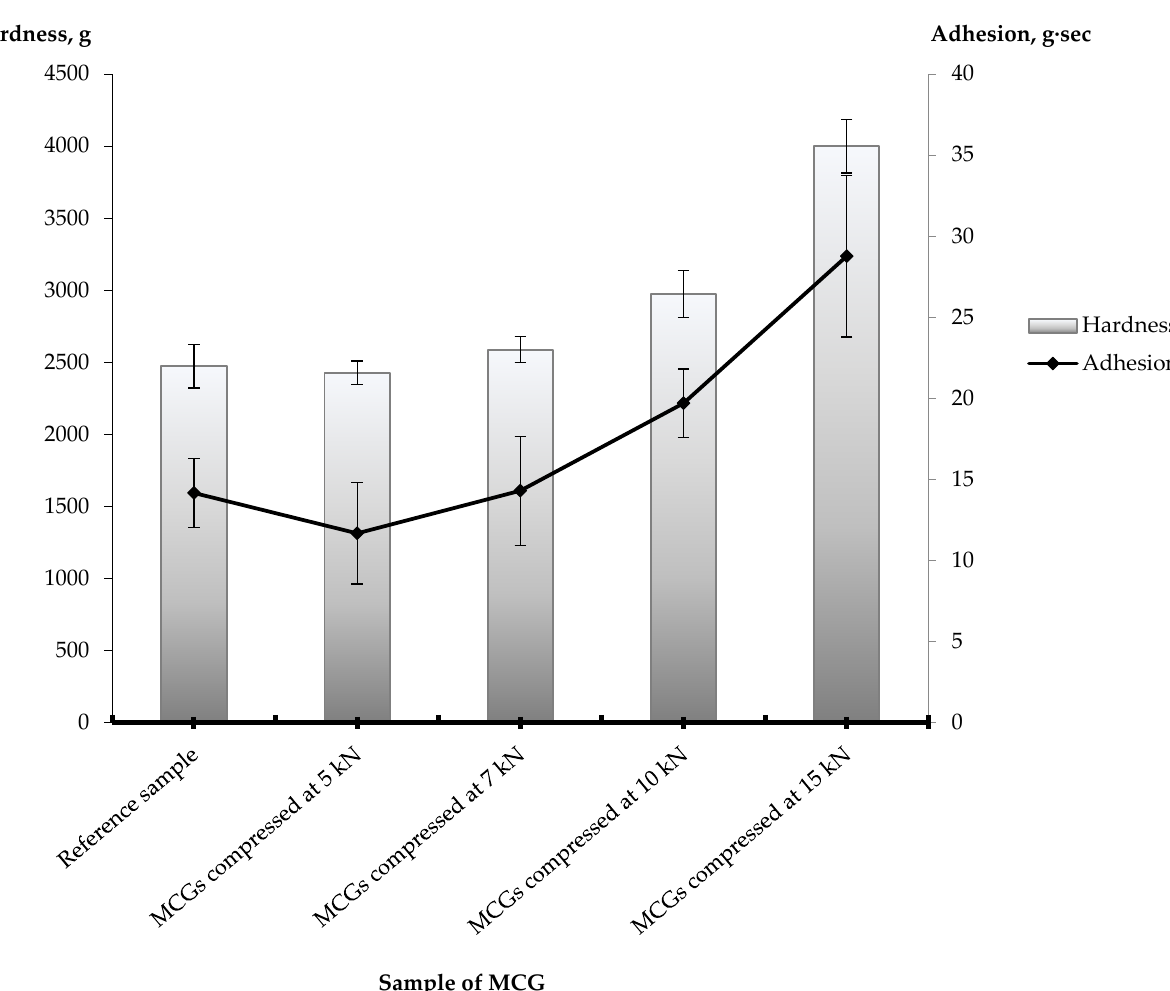
Figure 2. Comparative textural profile analysis of MCGs with LH and AsA compressed at different compression force values and a functional chewing gum “XD Extra Drive AntiStress Relax” (the values are mean ± SD, n = 3, p < 0.05).